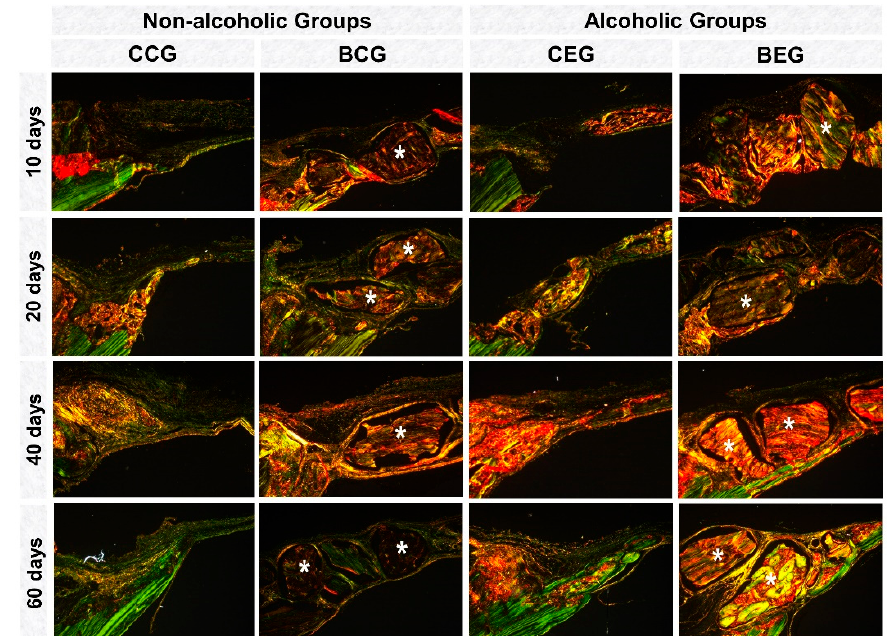
Figure 6. Photomicrographies of birefringent fibers stained with Picrosirius red under polarized light at 10, 20, 40 and 60 days of repair. In the initial periods, non-alcoholic groups, CCG and BCG showed red-orange collagen fibers becoming yellow-green at the end of the experiment. Alcoholic groups demonstrated evidently disorganized bone collagenous matrix, with red-orange birefringence around the grafted biomaterial (asterisk) and adjacent to the defect edges, CCG; BCG, at 60 days. The xenogeneic graft (BCG; BEG) presented red-orange birefringence. Picrosirius red staining, original magnification ×5. Scale bar = 50 µm.